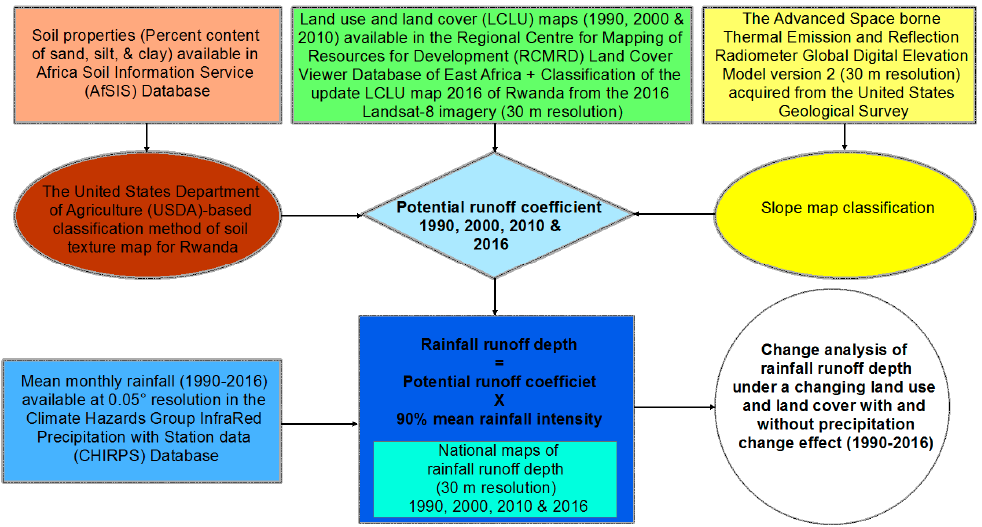
Figure 2. A flowchart used for modeling rainwater runoff in Rwanda.